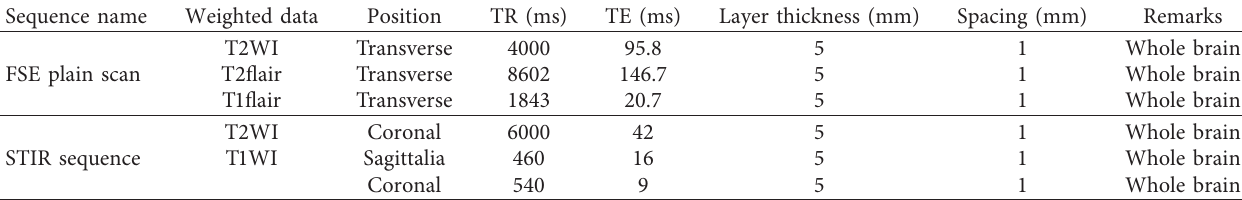
Table 2: Sequence parameters of brain